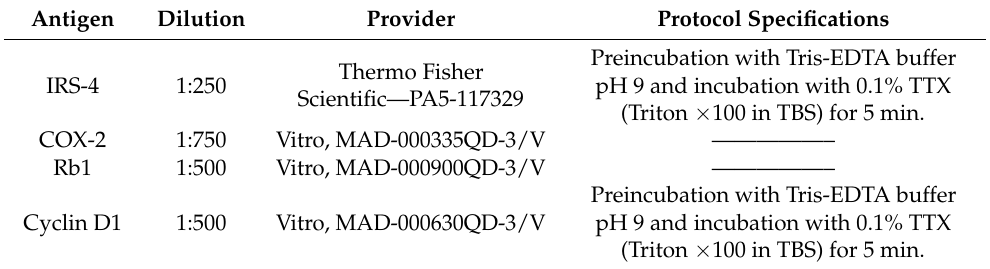
Table 1. Primary antibodies used, together with the dilutions and protocol